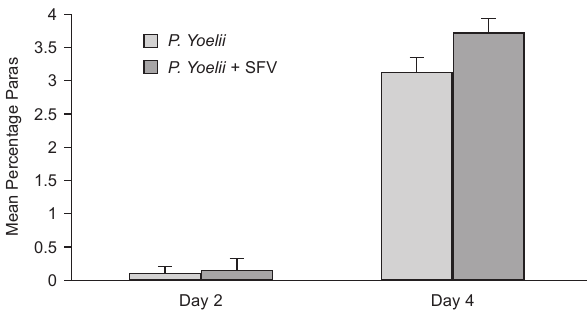
Fig. 2. – Parasitaemia in mouse blood. (Bar represent ± SE, 10 ani- mals in each group).